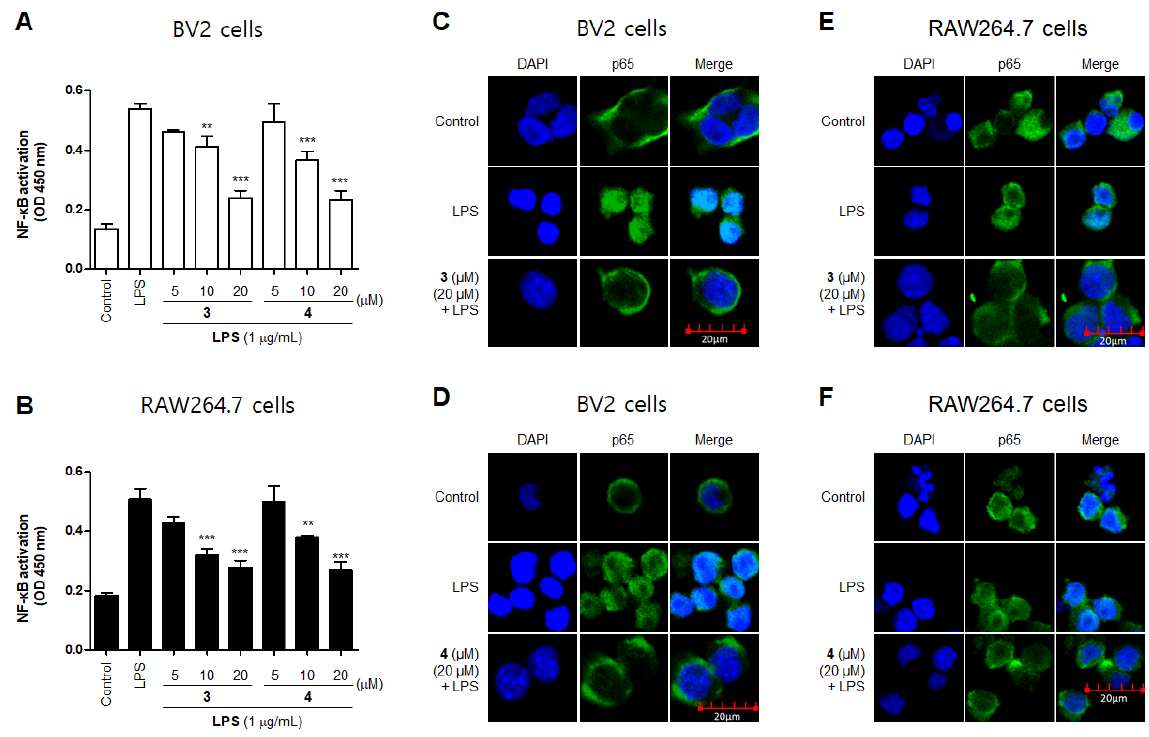
Figure 6. Effects of compounds 3 and 4 on and NF- κB DNA -binding activity ( A and B ) and NF- κB (p65) localization ( C – F ) in BV2 and RAW264.7 cells. The cells were pretreated with compounds 3 or 4 for 2 h and stimulated with liposaccharide (LPS; 1 μg/mL) for 1 h. Experiments were performed using a commercially available enzyme -linked immunosorbent assay kit, as described in the Materials and Methods section. ** p and *** p < 0.001 compared with the LPS-treated group.